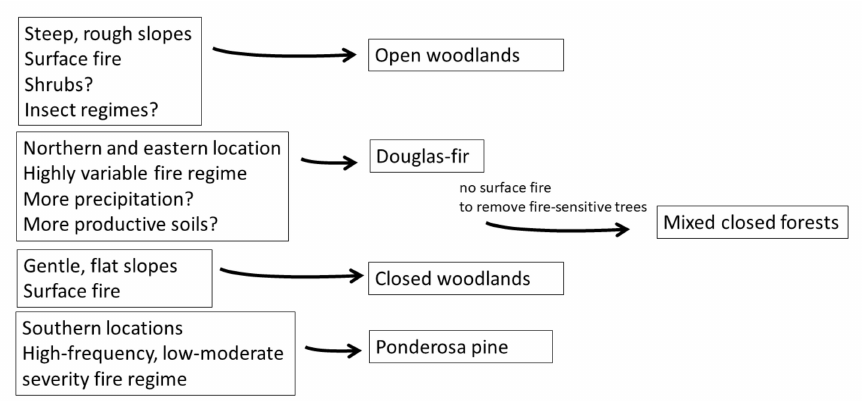
Figure 5. Proposed mechanisms for generating alternative past and current forest ecosystem